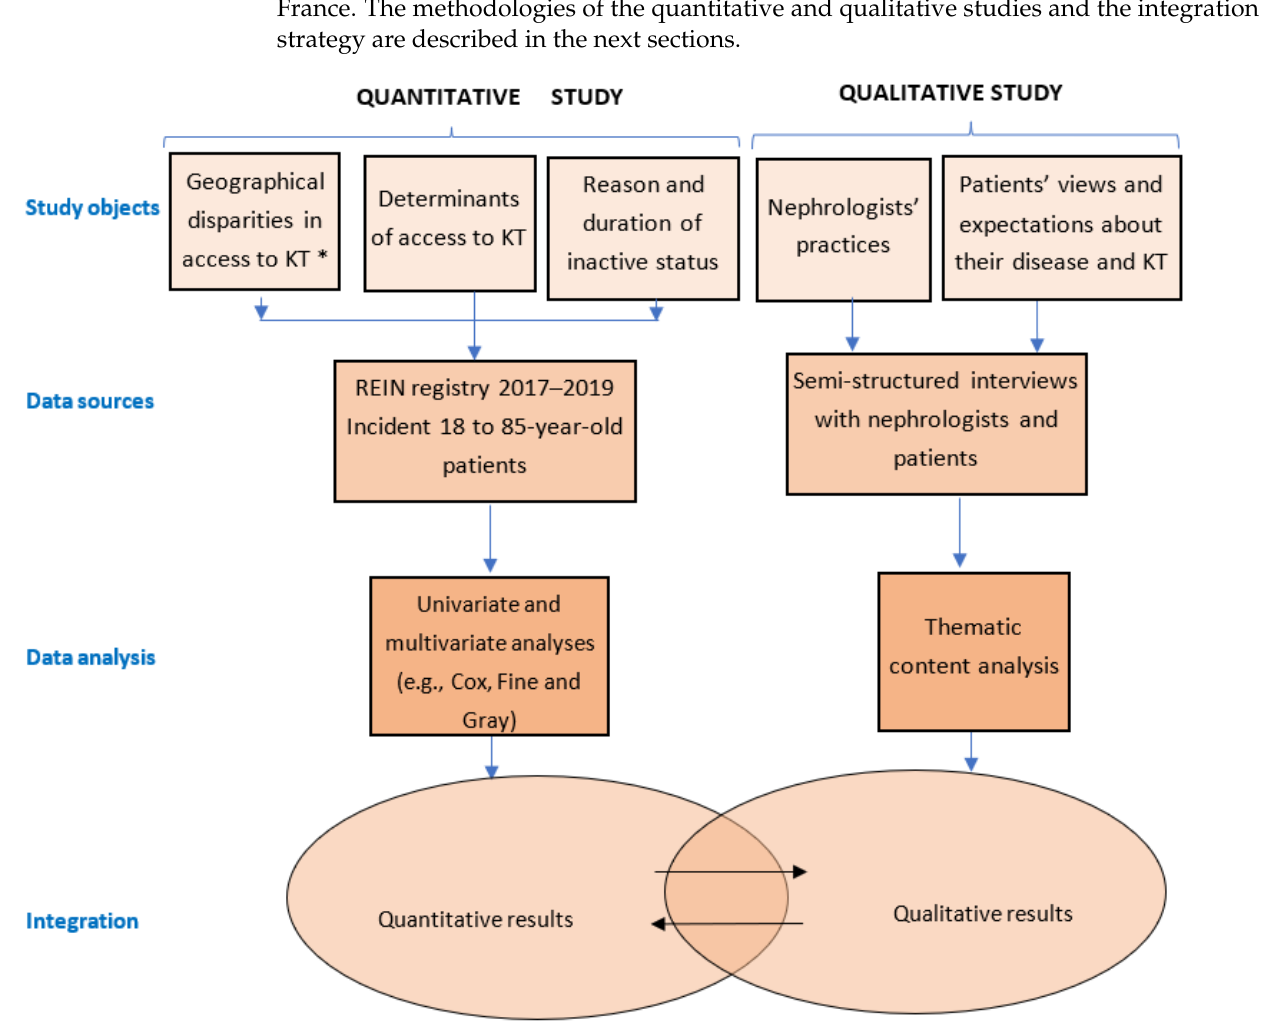
Figure 1. Mixed methods design. The quantitative and qualitative studies will be performed simultaneously. * KT: Kidney Transplantation (including access to the waiting list and access to kidney transplantation).